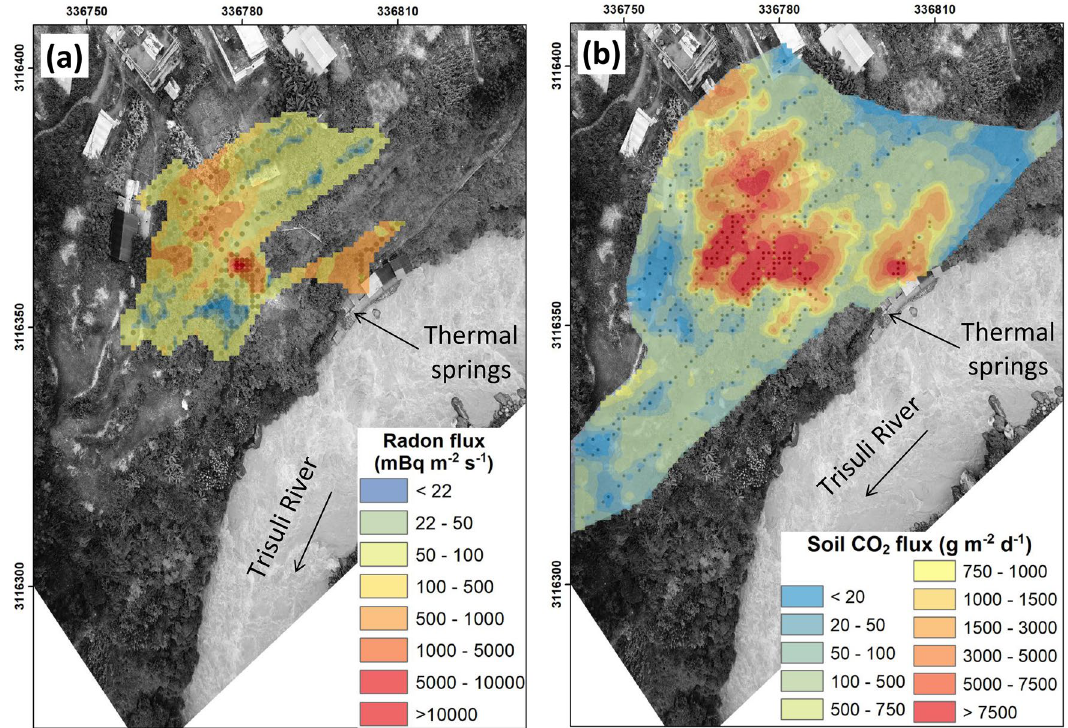
Figure 4. Interpolated (a) radon and (b) CO 2 flux maps of SBHS. For each flux map, the colour scale is shown on the bottom right. The map is projected following the UTM coordinate system. The map was built using sGs method with a cell size of 1 m 2 (see “Methods”